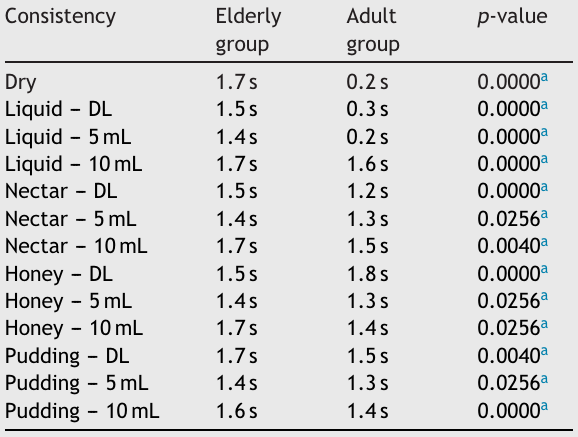
Comparison between the elderly (GI) and adult (GII) groups for time